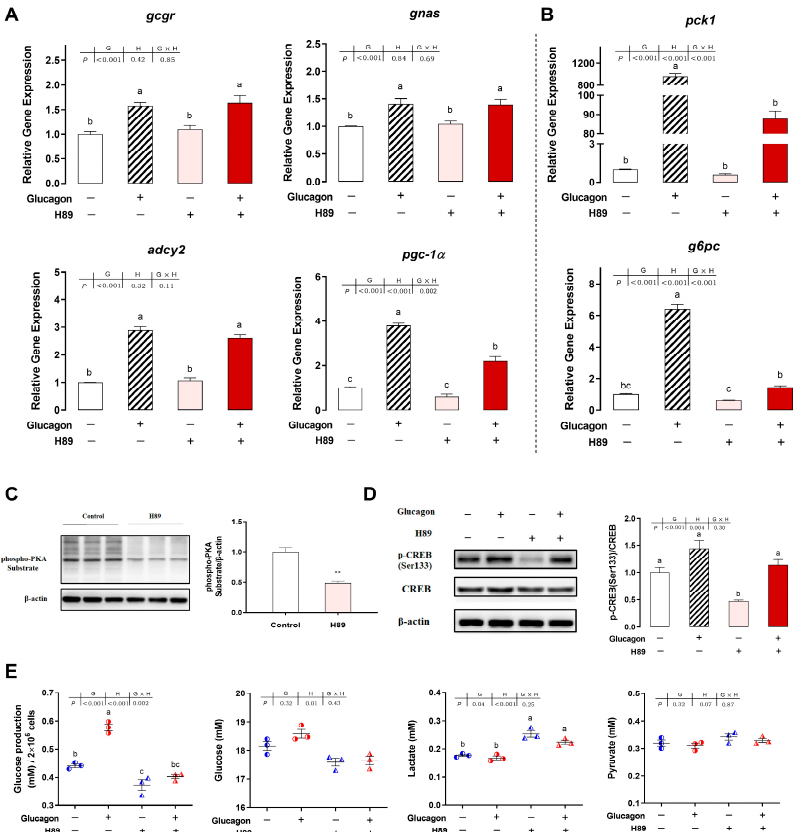
Figure 6. H89 inhibits the glucagon pathway in hepatocytes by targeting PKA. ( A ), qPCR analysis of the mRNA levels of glucagon pathway-related genes ( gcgr ; gnas ; adcy2 ; pgc-1 α ) following glucagon stimulation and treatment with H89 (20 µ M) in hepatocytes. ( B ), qPCR analysis of the mRNA levels of gluconeogenic genes ( pck1 and g6pc ) following glucagon stimulation and treatment with H89 (20 µ M) in hepatocytes. ( C ), Western blot analysis of a phospho-PKA substrate treated with H89 (20 µ M) in hepatocytes. ( D ), Western blot analysis of p-CREB (Ser 133 ) following glucagon stimulation and treatment with H89 (20 µM) in hepatocytes. ( E ), Glucose production in hepatocytes and glucose, lactate, and pyruvate concentrations in the medium following glucagon stimulation and treatment with H89 (20 µM). All data are expressed as mean ± SE, n = 3. For ( A , B , D , E ), p values were determined by two-way ANOVA with Tukey post-hoc test. Values with di ff erent le tt ers mean statistical di ff erences ( p < 0.05). G: glucagon treatments; H: H89 treatments; G × H: interaction between glucagon and H89 treatments. For C, p values were determined by